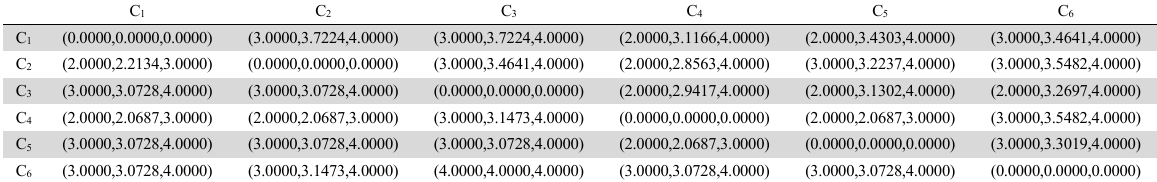
Average of expert opinions